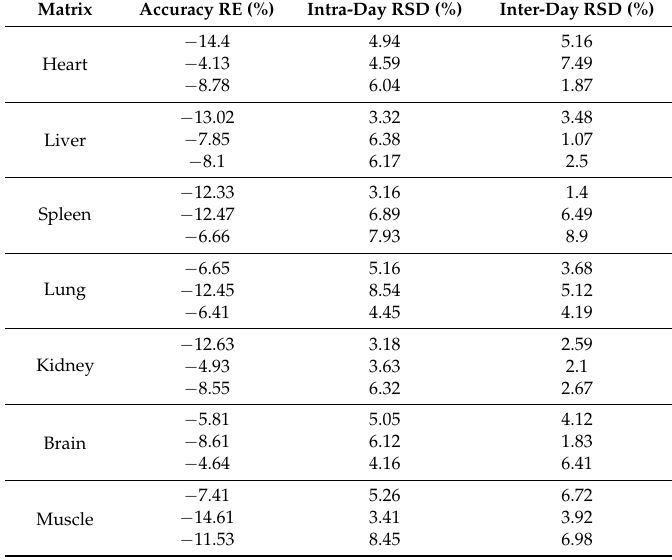
Table 5. Precision and accuracy for determination of RUS in rat plasma and tissues by FLISA Method (n =